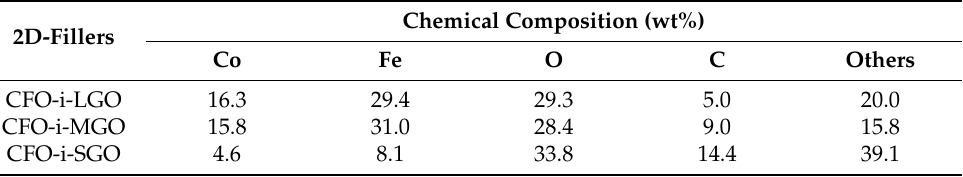
Table 1. Amount of chemical composition in the 2D magnetostrictive fillers of CFO-i-LGO, CFO-i- MGO, and CFO-i-SGO confirmed by energy-dispersive X-ray spectroscopy (EDX)